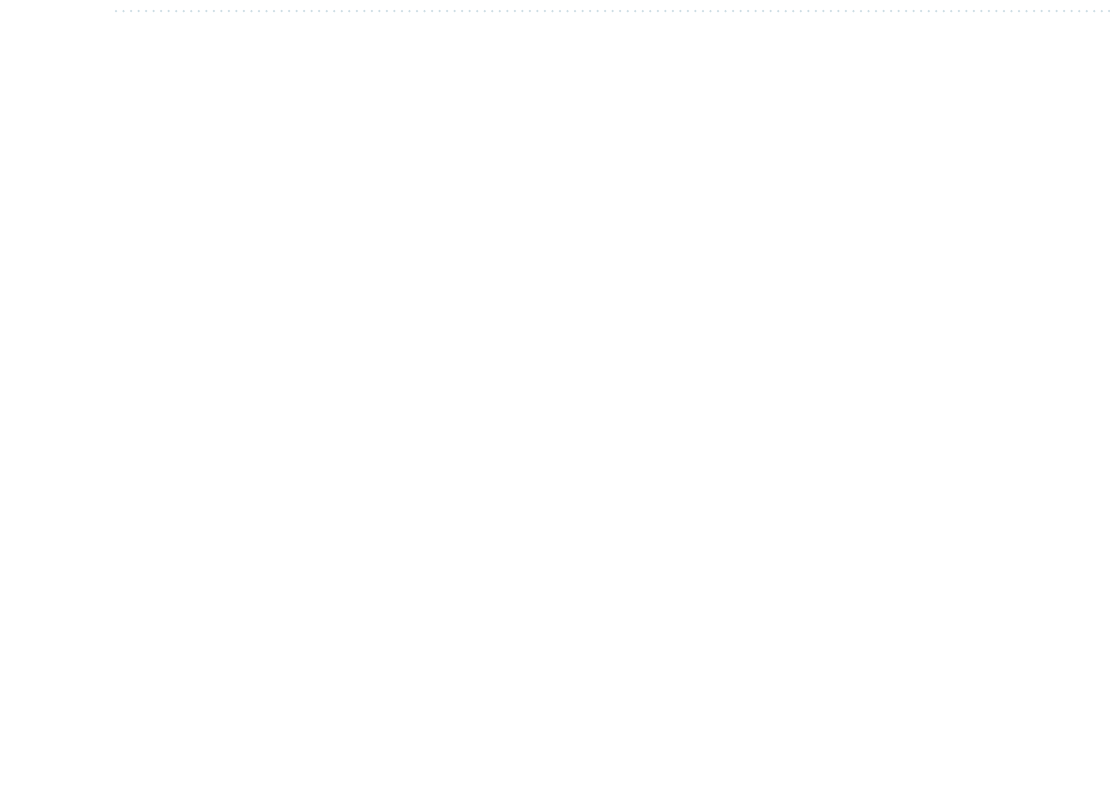
Figure 6. Impacts of ∅ on Y (ζ) for ( a ) opposing ( b ) assisting and ( c ) static